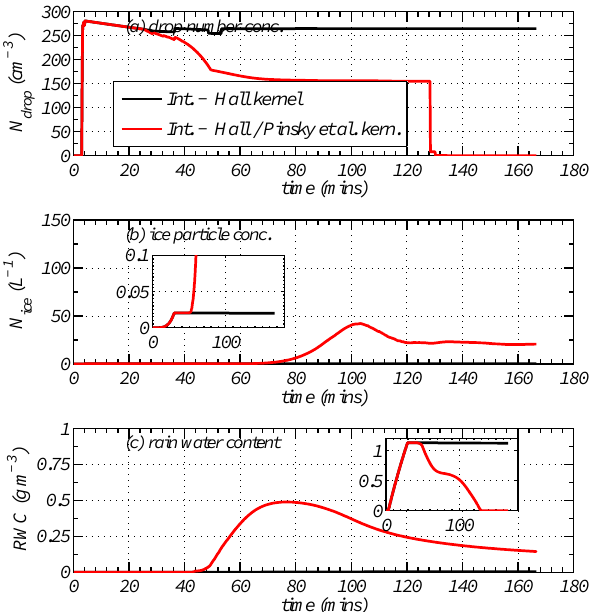
Fig. 15. As Fig. 12, except the three runs correspond to different numbers of primary IN (i.e. DeMott et al. × 1, 10 and 100). It can be seen that in all cases similar amounts of ice are eventually produced in the